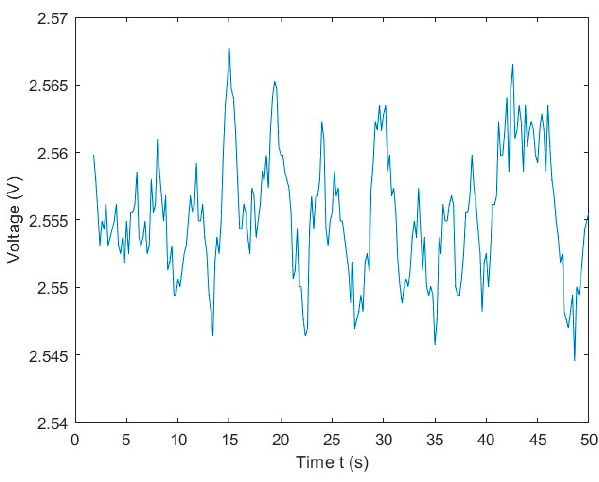
Figure 16. Voltage variation in the ACS712-05 sensor for I = 0 A after calibration.